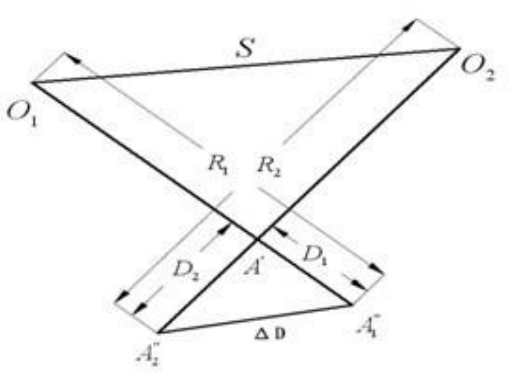
Figure 2. The same object project onto a different frame (Looking down at the surface) When a strip of images have been processed, the model of the adjacent images is showed in Figure 2, in which A is the object, , are the principal points of the neighbouring images. S is the baseline.